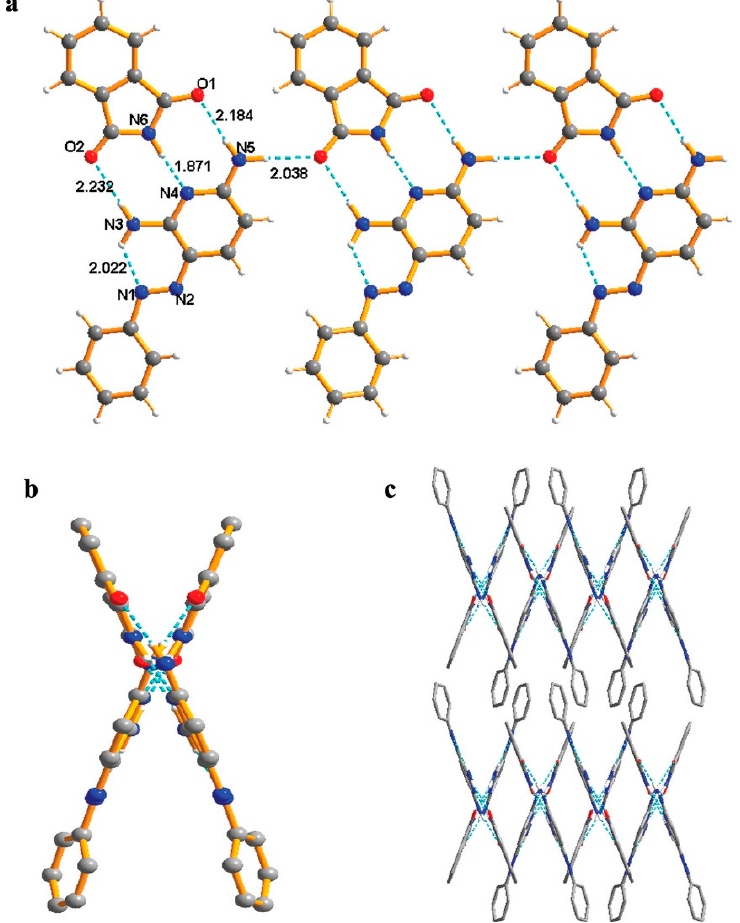
Figure 11. Phenazopyridine-phthalimide co-crystal structure. ( A ) Side view of hydrogen bond linked chain, ( B ) Top view of scissor-like chain, and ( C ) 3D structure of co-crystal. Reprinted (adapted) with permission from [96]. Copyright 2012, American Chemical Society.